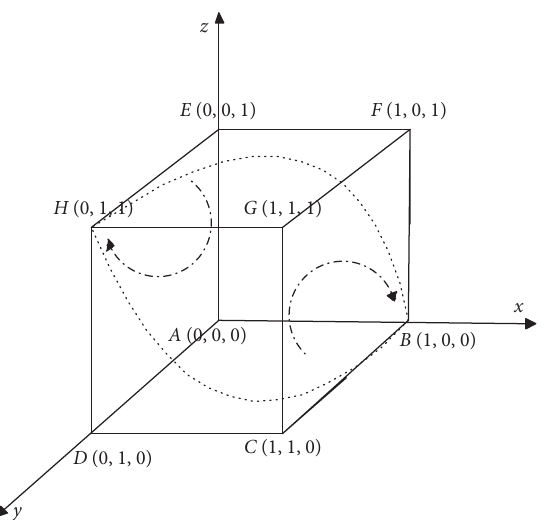
Figure 5: Dynamic phase diagram of stability evolution replication of local government, new media, and local